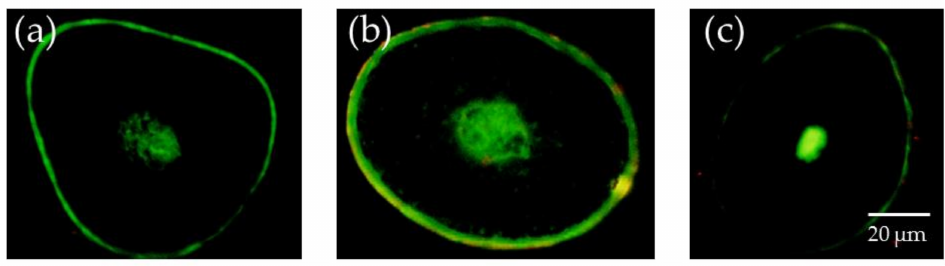
Figure 1. Unsaturated lipid content of each cross-section of hair (200 × magnification). ( a ) Hair tip; ( b ) middle of the hair; and ( c ) hair